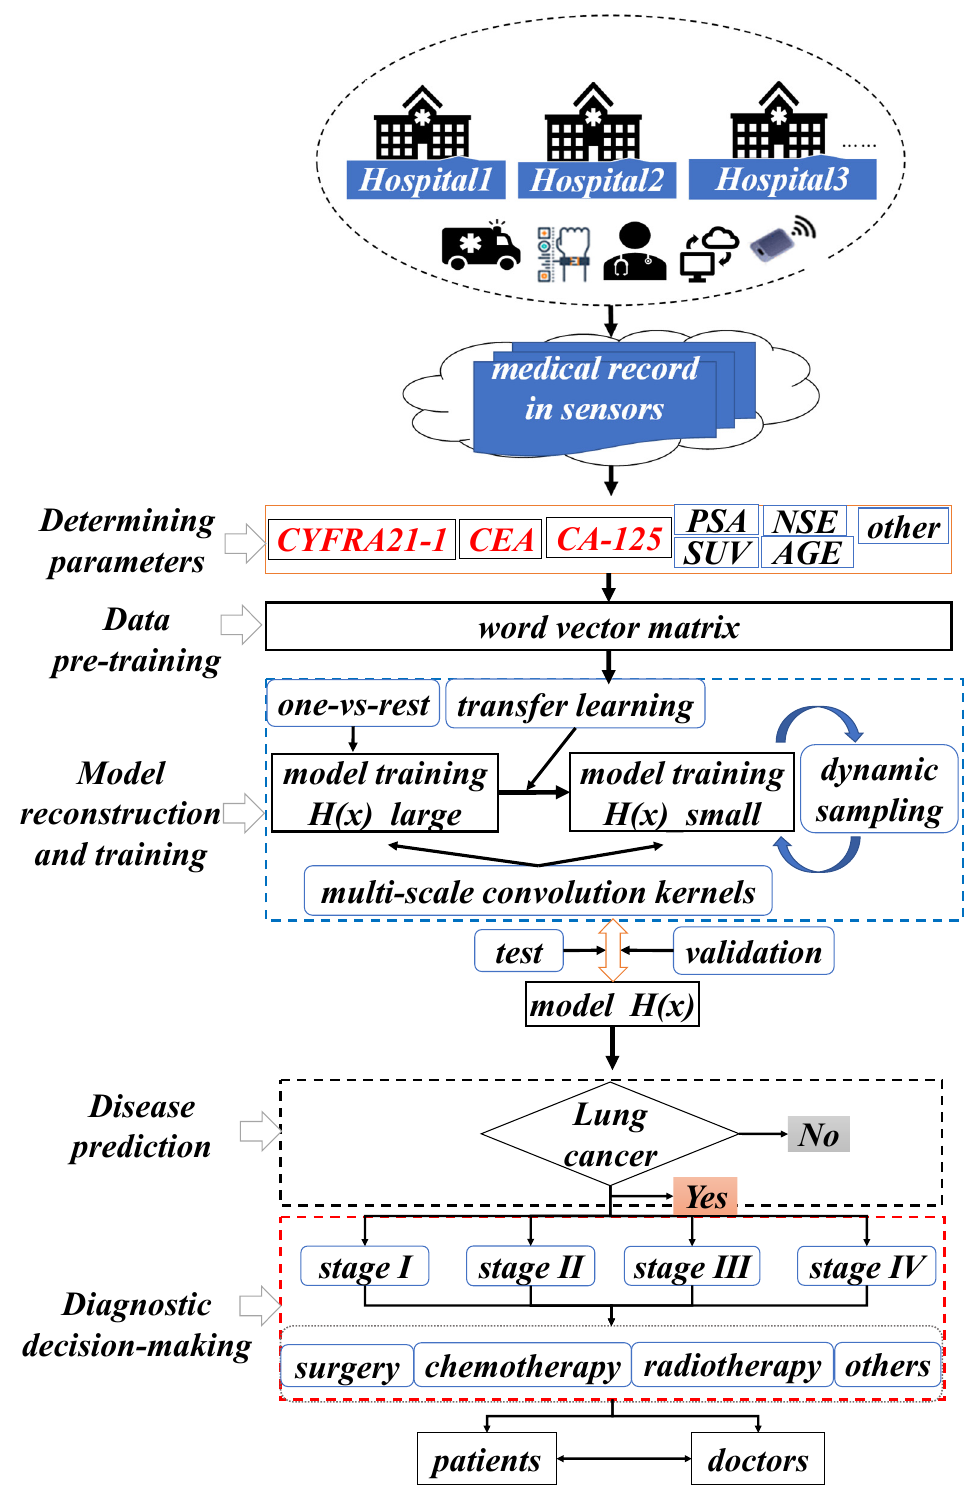
Figure 1. Framework diagram of the intelligent medical system used for the assisted diagnosis and decision-making of NSCLC.